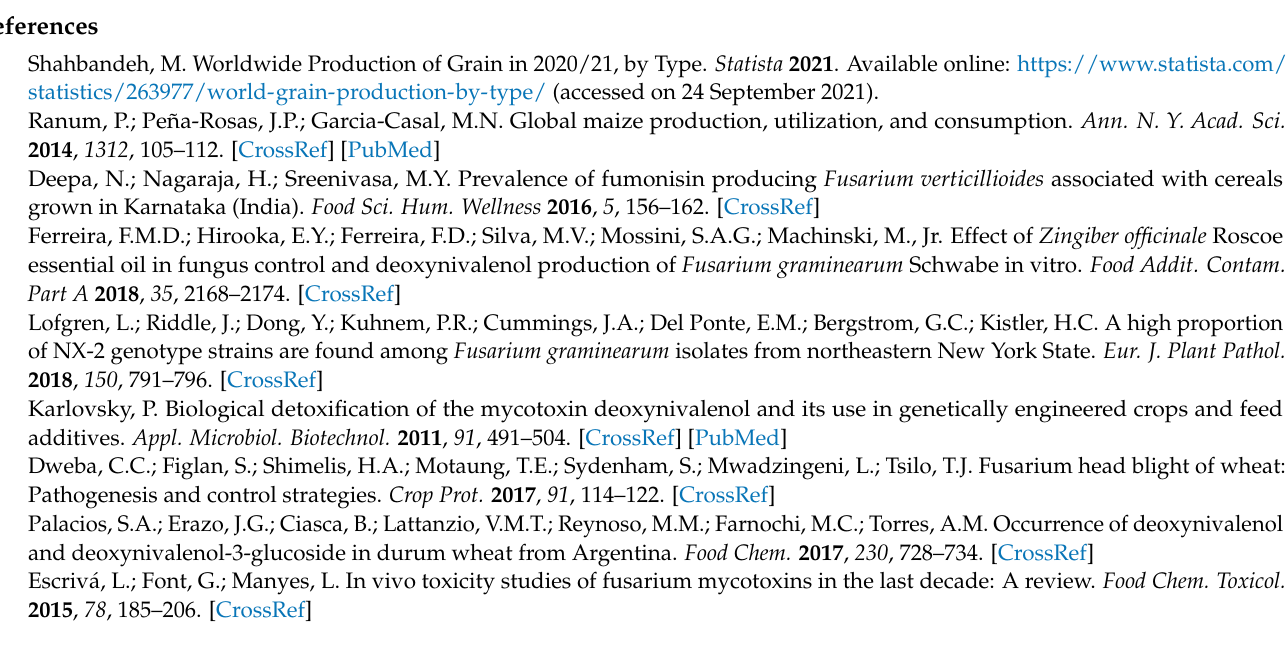
Figure S2. Morphology of F. graminearum hyphae under optical microscope (magnification ×